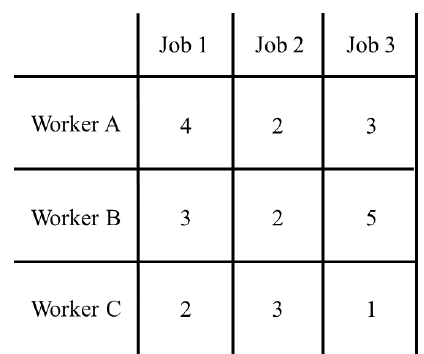
Figure 8. Example of a cost matrix for assigning a job to a worker. Our system assigns identities between two consecutive frames, using predicted positions from the first frame and detected positions from the second frame as the workers and the jobs. The cost will be the distance between all possible pairs of positions.